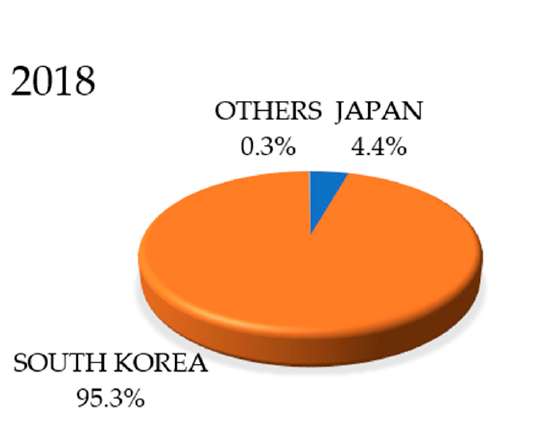
Table 2. Evaluating of wood pellet demand by increasing export and domestic use